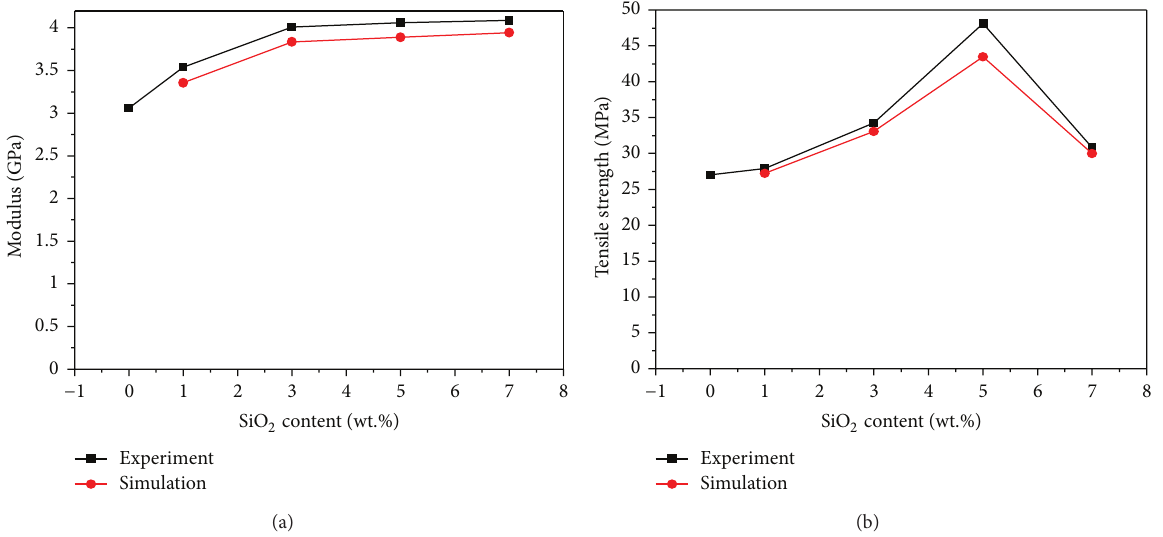
Figure 8: Nanocomposite failure diagrams and corresponding stress-strain curves for different particle contents: (a), (b), (c), and (d).